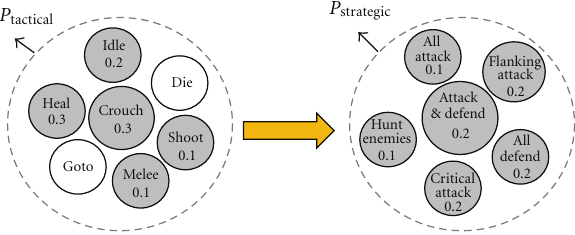
Figure 8: An example of Strategic Agent Personality (SAP). This diagram shows the di ff erences between the fundamental Tactical Agent Personality (left) and Strategic Agent Personality (right). For the TAP, each action is tagged with a relative weight that can be evaluated into a probability of choosing it. The shaded ones are the adaptable actions whilst the unshaded ones are nonadaptable. The SAP is similarly defined.